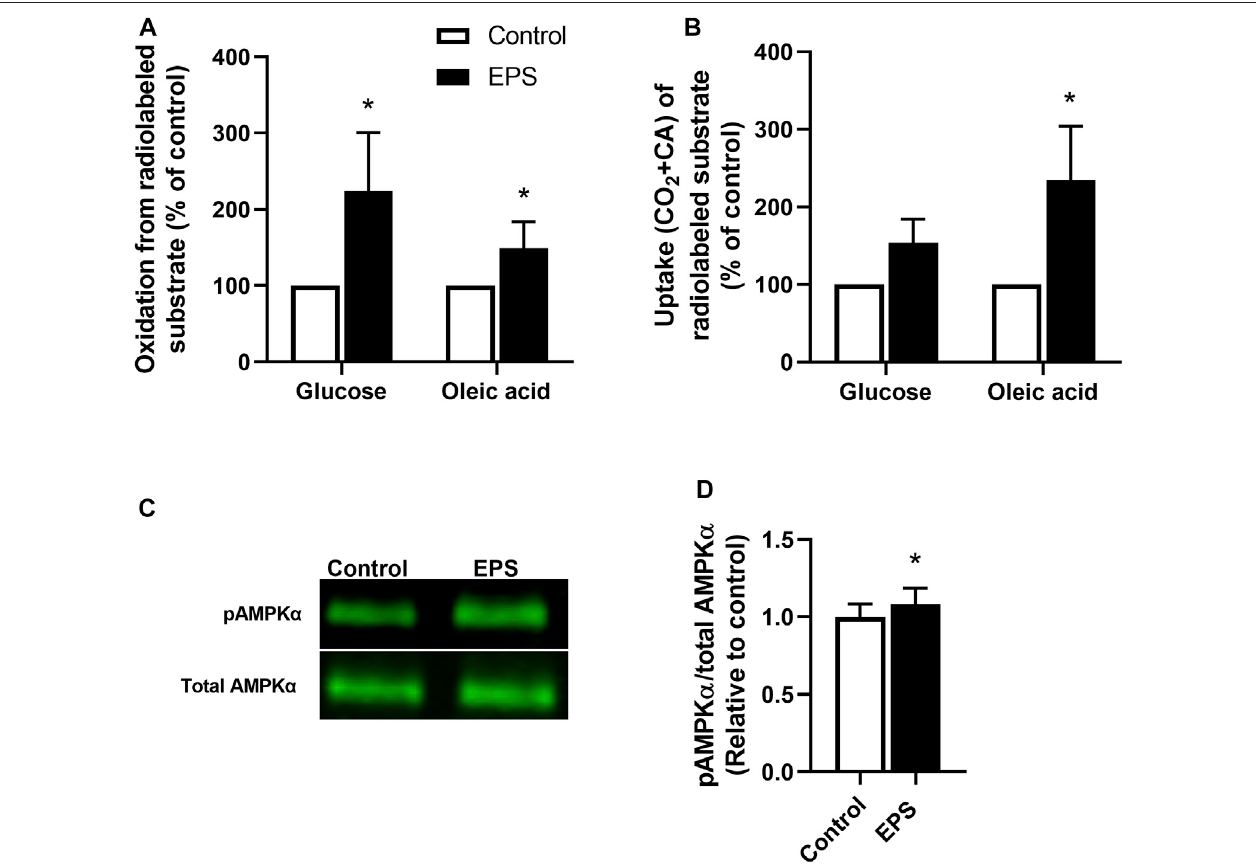
FIGURE 1 | Changes in substrate metabolism and phosphorylation of AMP-activated protein kinase (AMPK) in myotubes after electrical pulse stimulation (EPS). Human myotubes from youngmalesubjectswerecultured on6-wellplates andexposedtoEPS protocol1(2 ms,10 Vand0.1 Hzfor24 h). (A,B) AfterEPS,myotubes were incubated with a medium containing [ 14 C]glucose (0.5 μ Ci/ml, 200 μ M) or [ 14 C]oleic acid (0.5 μ Ci/ml, 100 μ M). Cell-associated (CA) radioactivity and trapped CO 2 (oxidation) were measured as described in methods. (A) Oxidation of glucose and oleic acid after EPS. Data are expressed as mean ± SEM, normalized to unstimulated control cells (absolute values: glucose; 0.39 ± 0.17 nmol/mg protein and oleic acid; 0.32 ± 0.14 nmol/mg protein). (B) Glucose and oleic acid uptake quanti fi edasthesumoftrappedCO 2 andtheremainingCAradioactivityincells.Valuesarepresentedasmean±SEM,normalizedtounstimulatedcontrolcells(absolute values: glucose 25.4 ± 11.4 nmol/mg protein, oleic acid 103.7 ± 46.4 nmol/mg protein). (C,D) Aliquots of total cell lysates were prepared in Laemmli buffer and electrophoretically separated before phosphorylation of AMPK α was assessed by immunoblotting using a phospho-speci fi c AMPK α Thr172 antibody. (C) Representative immunoblots and (D) quanti fi ed protein expression of AMPK α Thr172 phosphorylation. Expression of pAMPK α Thr172 was normalized to total AMPK α Thr172 expression. All results are presented as mean ± SEM from fi ve ( n = 5, (A,B) and six ( n = 6, (D) individual experiments. *p < 0.05 vs. control.